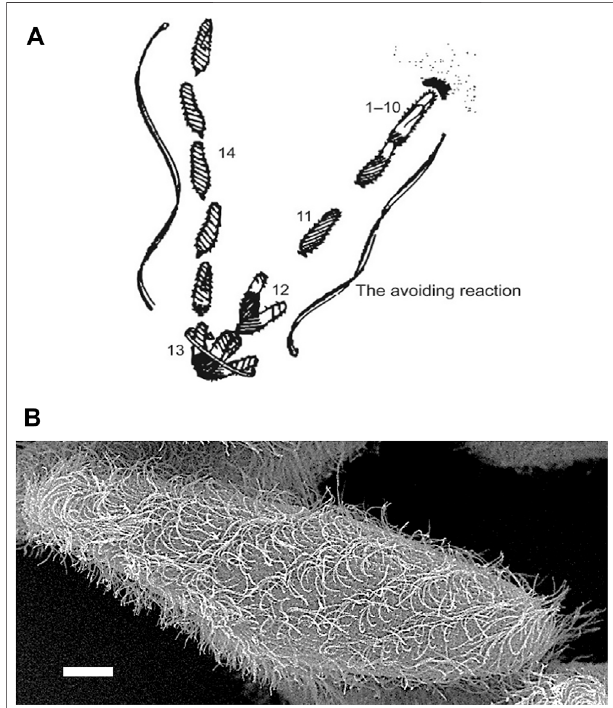
FIGURE 1 | (A) An image based on the sketch of the stages of the avoiding reaction drawn by Jennings (Jennings, 1906). Anterior mechanical stimulation by a cell swimming into an object leads to depolarization, opening of the Ca V channels of the cilia, movement of the cell backward for a short time, twirling in place, and forward movement in a new direction. From Eckert (Eckert, 1972). (B) Scanning electron micrograph image of Paramecium showing metachronal waves of cilia (Courtesy of M. S. Valentine.).